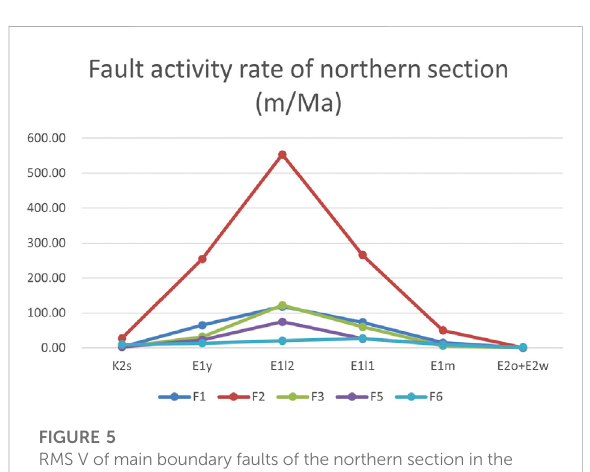
FIGURE 5 RMS V of main boundary faults of the northern section in the Lishui West